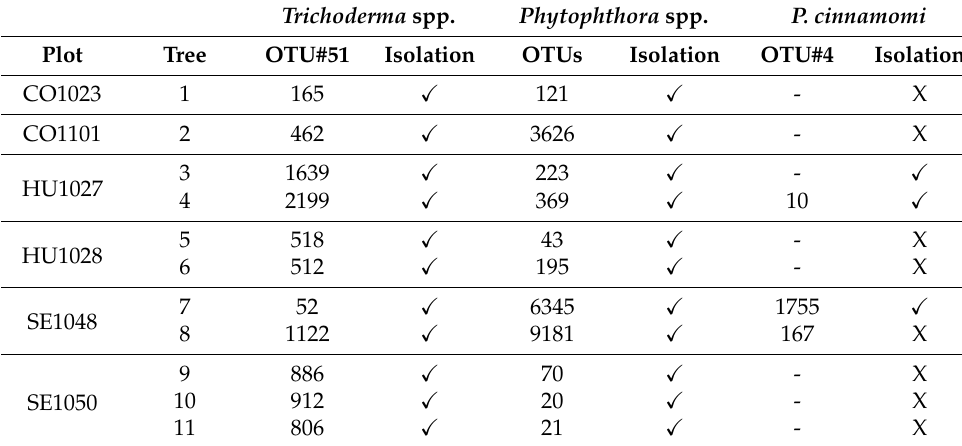
Table 2. Comparison between previous metabarcoding results [33] and classic isolation from soil samples. OTU: operational taxonomic unit resulting from the consensus sequence clustering of the metabarcoding analysis of soil DNA for fungal and oomycete communities. Numbers represent the frequency of the OTUs appearing in the rarefied abundance matrix. The symbol # indicates that frequencies refer to a single OTU (OTU#51: Trichoderma sp., OTU#4: P. cinnamomi ). Trichoderma spp. Phytophthora